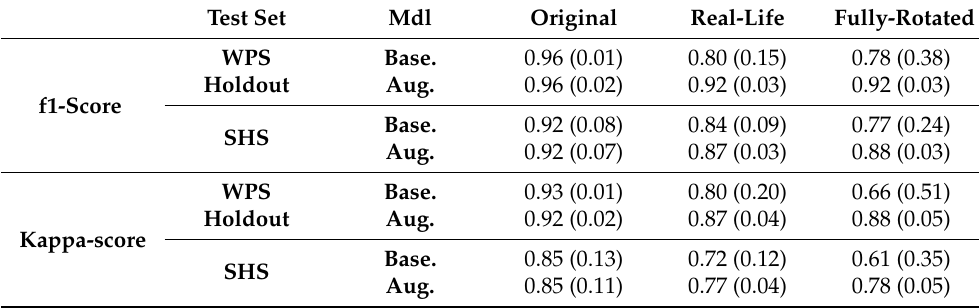
Table A2. Median and IQR of f1-score and Kappa-score according to the two holdout sets and three test sets.